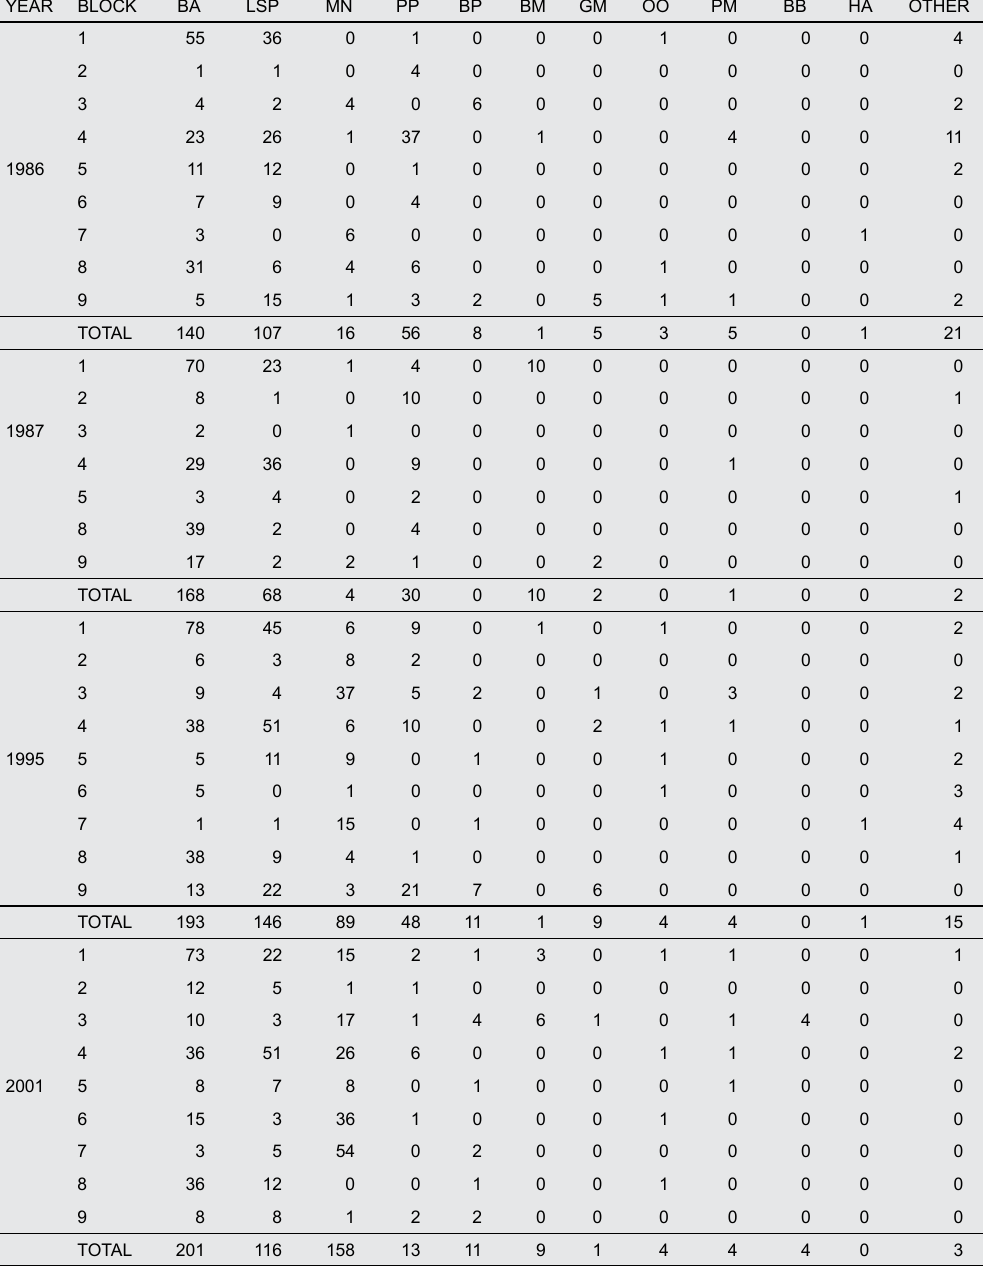
Table 2. Sightings of cetacean groups in Icelandic aerial surveys, 1986-2001. Only primary (rear seat) sightings are shown. BA – minke whales; LSP – Lagenorhynchus spp. dolphins, mainly L. albirostris ; MN – humpback whales; PP – harbour por- poises; BP – fin whales; BM – blue whales; GM – long-finned pilot whales; OO – killer whales; PM – sperm whales; BB – sei whales; HA – northern bottlenose